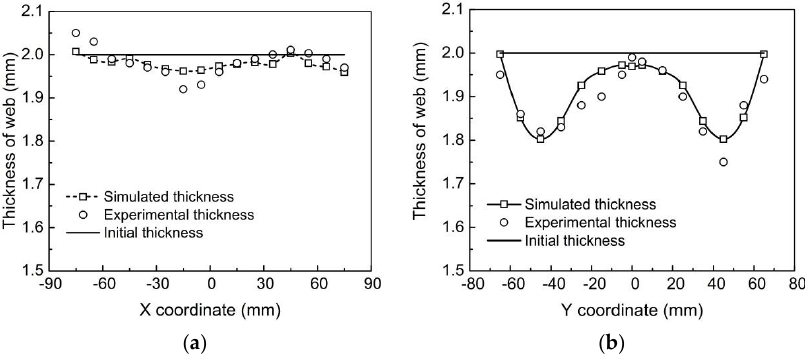
Figure 14. Comparison of web thickness between experimental and simulated results along: X center web-bottom path ( a ); and Y center web-bottom path ( b ).